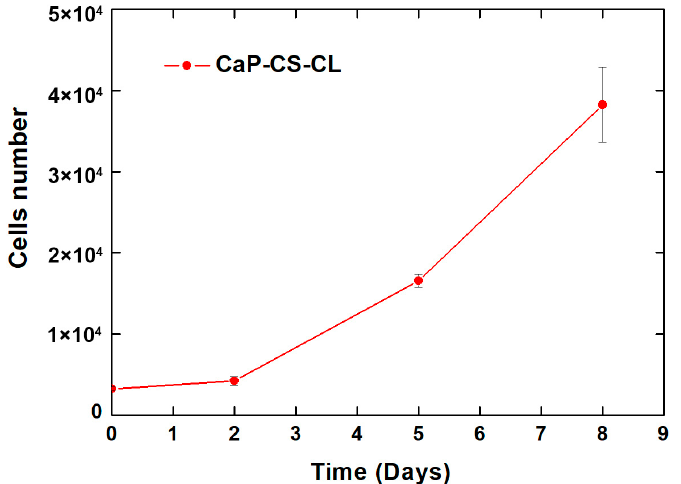
Figure 8. Viability, measured through AlamarBlue reagent, of MC3T3-E1 cells grown in CaP/CS/CL coating treated media.